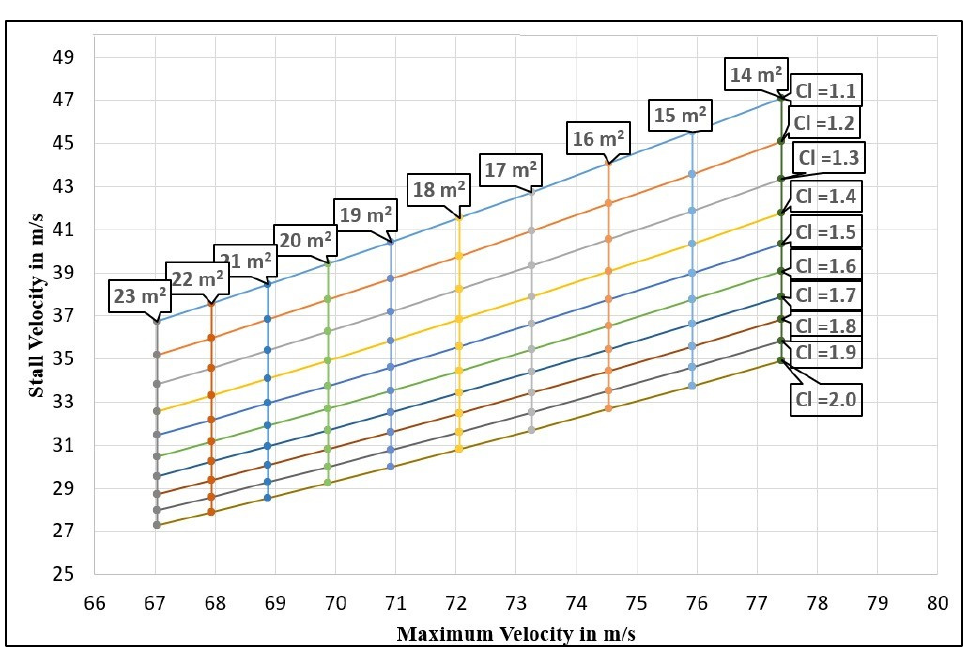
Figure 14. Stall speed—maximum cruise speed carpet plot.